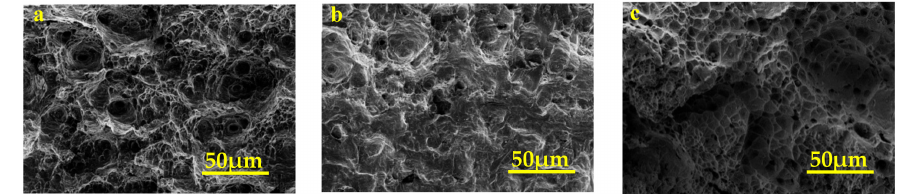
Figure 13. Fatigue final rupture zone surface of ( a ) 304 stainless steel substrate, ( b ) experimental materials and ( c ) comparative